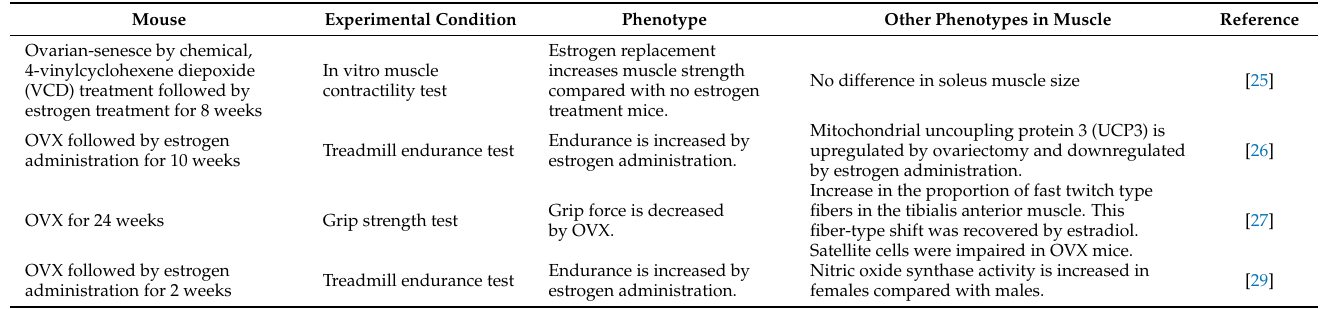
Table 1. Phenotypes of ovariectomized mice on muscle